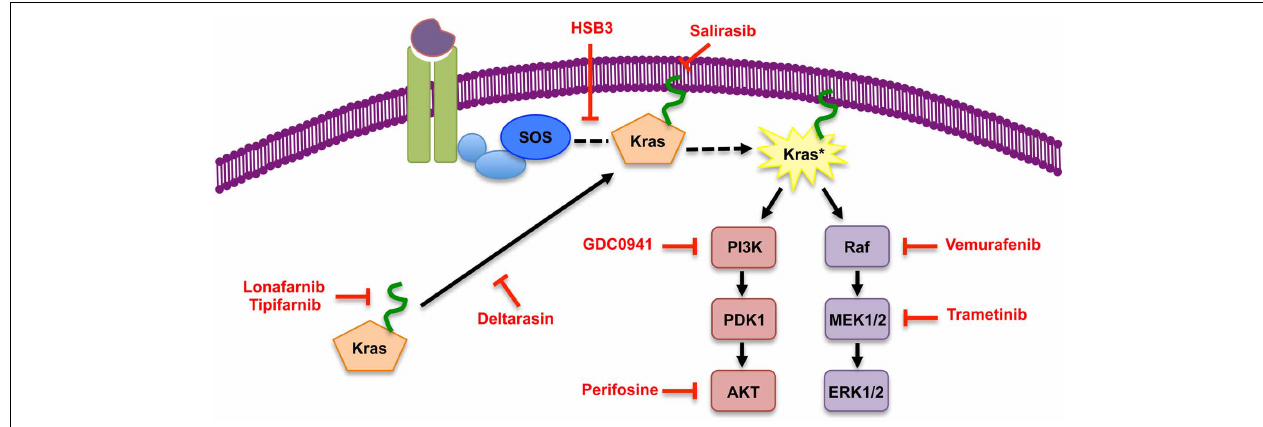
FIGURE 2 | Inhibitors of Kras and of its effector pathways. Simplified scheme of Kras signaling, with representative inhibitors of signaling components indicated in red. The inhibitor list is not